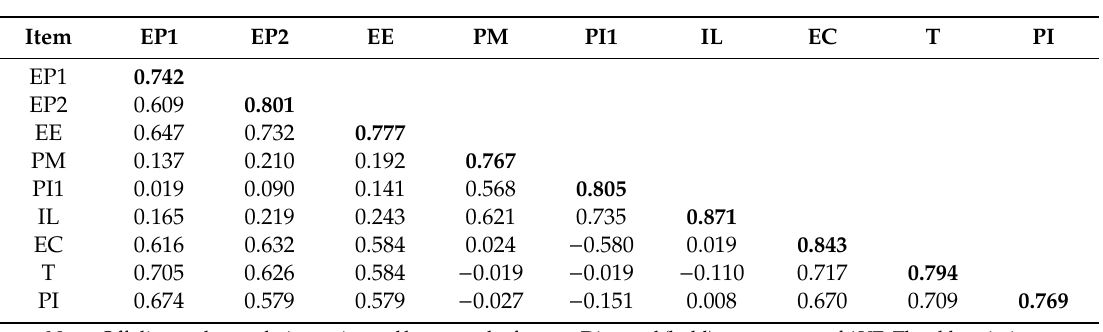
Table 2. Discriminant validity